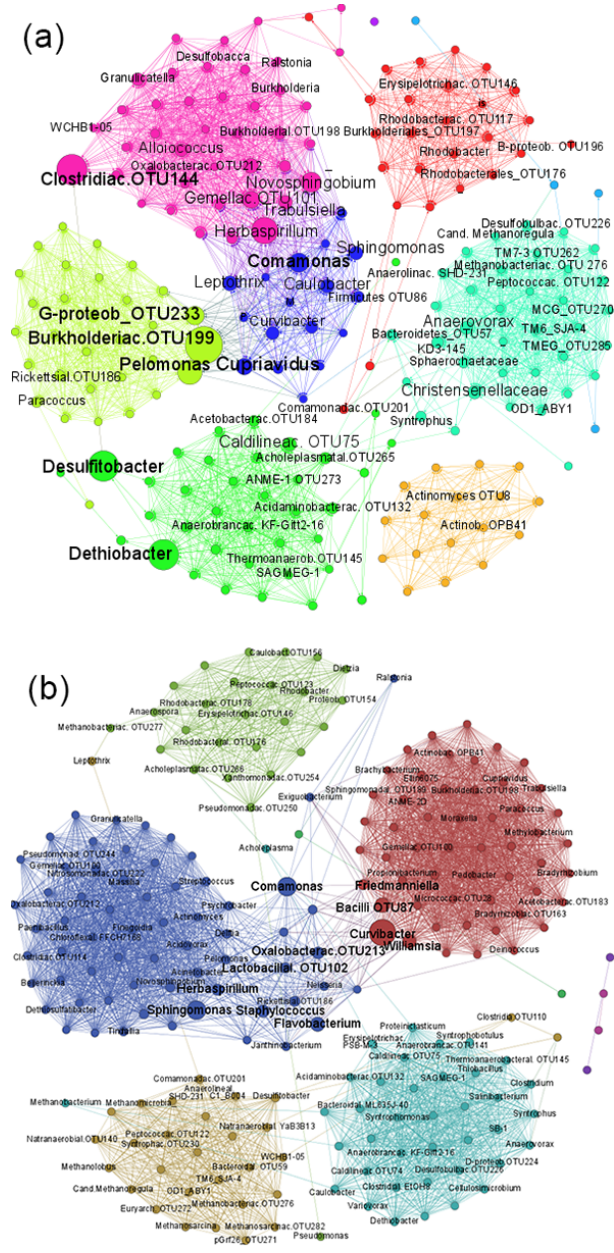
Figure 6. The co-occurrence network of the total (a) and active (b) microbial community in Outokumpu bedrock. The size of each node corresponds to the betweenness of centrality value of the OTU. The modules are represented by different colours.